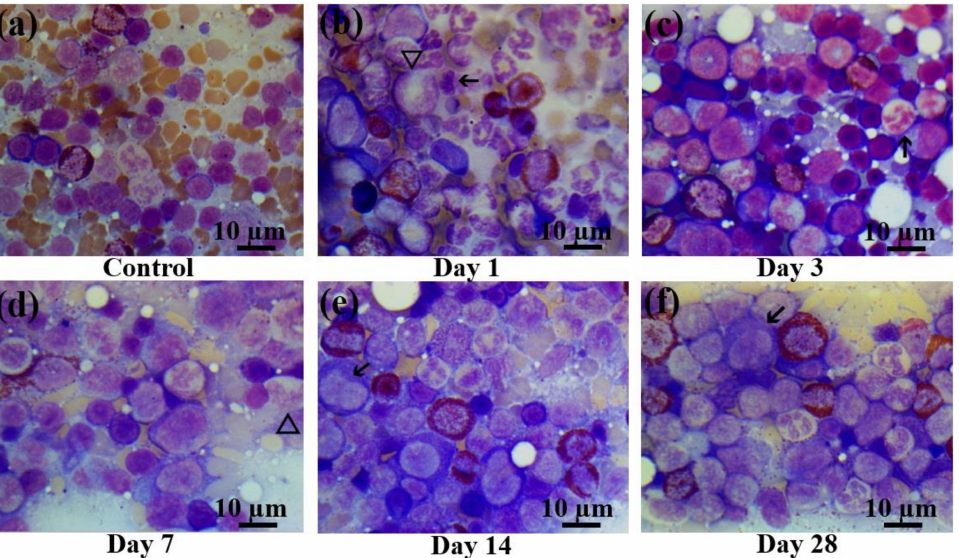
Figure 5. Bone marrow smears in control rats and those exposed to the laser-driven UPEB irradiation. ( a ) Control bone marrow smears. ( b ) 1st day after electron beam exposure: prominent proliferation of myeloid cells; lymphopenia, occurrence of destroyed cells. Pathological cells (arrowed) and giant neutrophils (triangle). ( c ) 3rd day after electron beam exposure: increased number of erythroid cells, lack of mature leucocytes; pathological neutrophil (arrowed). ( d ) 7th day after electron beam exposure: partial recovery of leucocyte population. Presence of giant neutrophils, with basophilic cytoplasm (triangle). ( e ) 14th day after electron beam exposure: partial recovery of lymphocyte population. Presence of pathological bilobed lymphoblasts (arrowed). ( f ) 28th day after electron beam exposure: recovery of leucocyte population; presence of pathological lymphocytes (arrowed). Bone marrow smears were stained by Giemsa modified solution. Cells were examined under the light microscope at 1250 × magnification. Scale bar is 10 µ